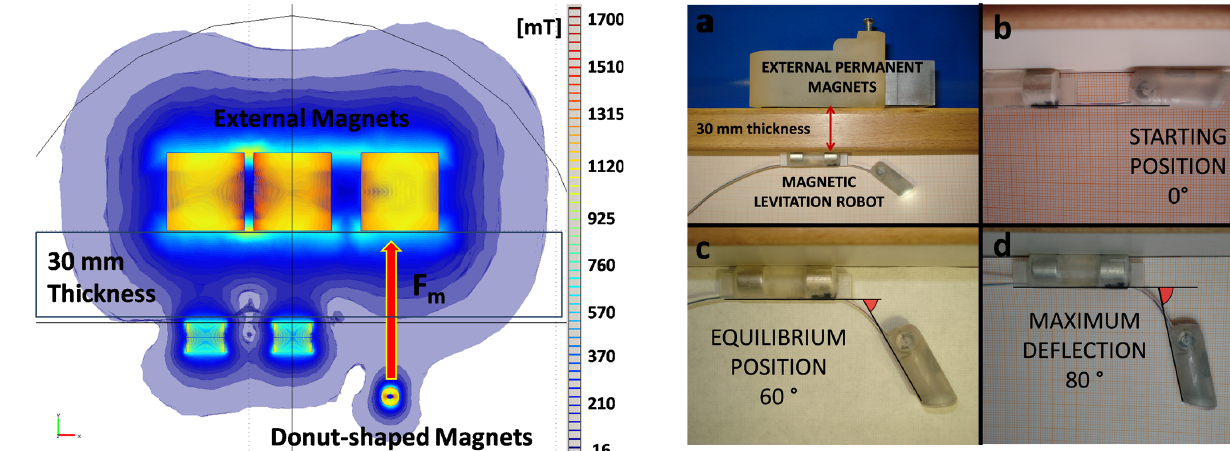
Figure 8. FEM analysis of the magnetic interaction between donut- shaped magnets and the external magnet in order to evaluate mag- netic force components ( F m ) for di ff erent equilibrium points. All the internal and external magnets were considered. The mesh con- sisted of about 1350000 elements with a minimum quality ratio of 0.3. In this screenshot is showed the magnetic attraction force eval- uation in the equilibrium point for a defined beam length of 24mm.